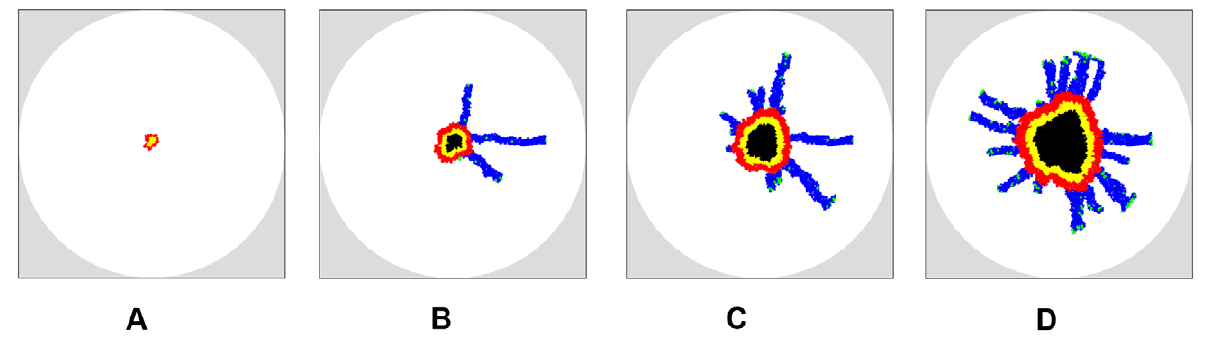
Figure 8. Evolution of simulated tumor in homogeneous ECM with r ECM ~ 0 : 85 . The mutation rate is c ~ 0 : 05 , the cell motility is m ~ 3 and ECM degradation ability is x ~ 0 : 9 . (a) Growing tumor on day 50. (b) Growing tumor on day 80. (c) Growing tumor on day 100. (d) Growing tumor on day 120. Note that although the ECM is homogeneous, due to its high rigidity, the primary tumor develops an anisotropic shape with protrusions in the proliferation rim caused by the invasive branches. Also note that the invasive cells clump at the tips of certain invasive branches due to the high ECM rigidity. Although we only consider spherical growth-permitting regions here, our tumor-growth simulations can incorporate growth-permitting regions with arbitrary shapes.